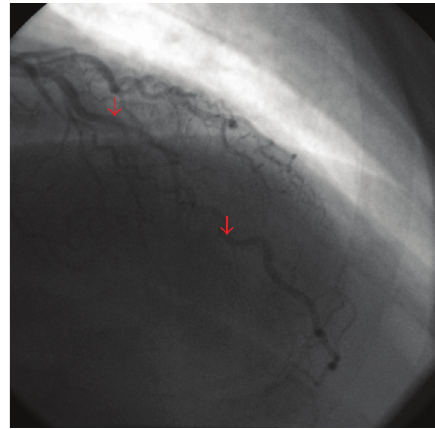
Figure 2: Systolic compression of LAD augmented during nitro- glycerin